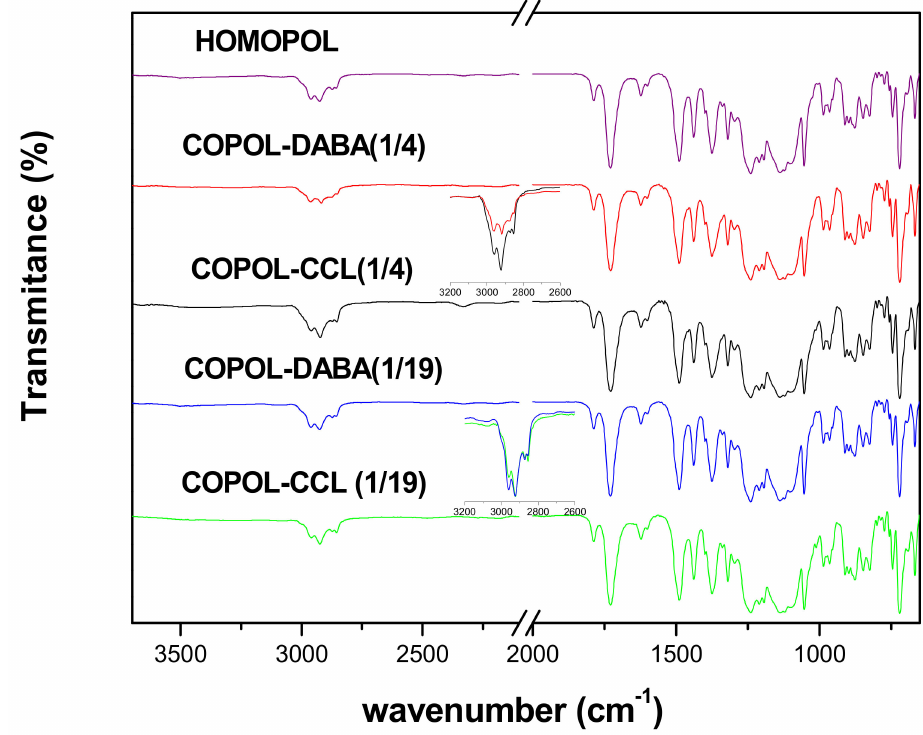
Figure 7. ATR-FTIR spectra for the homopolymer, the copolyimides, and the crosslinked homologs. The insets in the graphs show the broadened region around 2900 cm –1